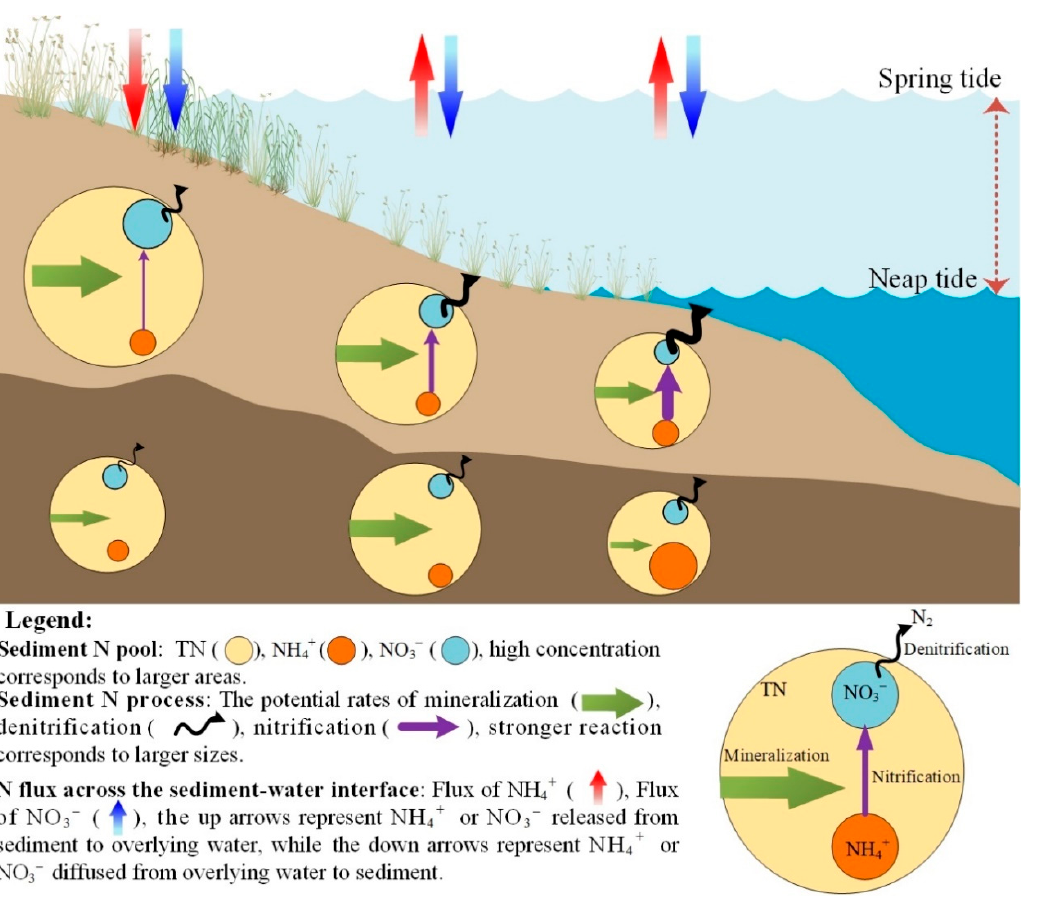
Figure 6. A conceptual schematic for the fate of nitrogen pools, processes, and fluxes in a tidal flat of a coastal wetland ecosystem.